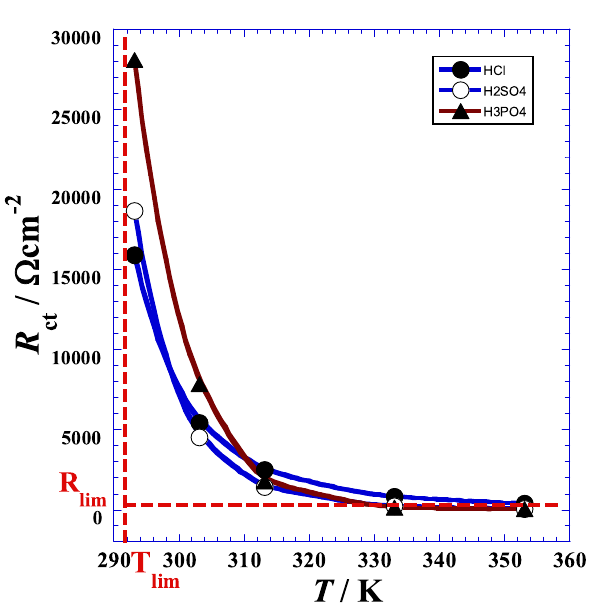
Figure 6. Variation of the charge transfer resistance ( R ct ) as a function of temperature ( T ) for different acids. ( ● ): HCl; ( ○ ): H 2 SO 4 ; ( ▲ ): H 3 PO 4